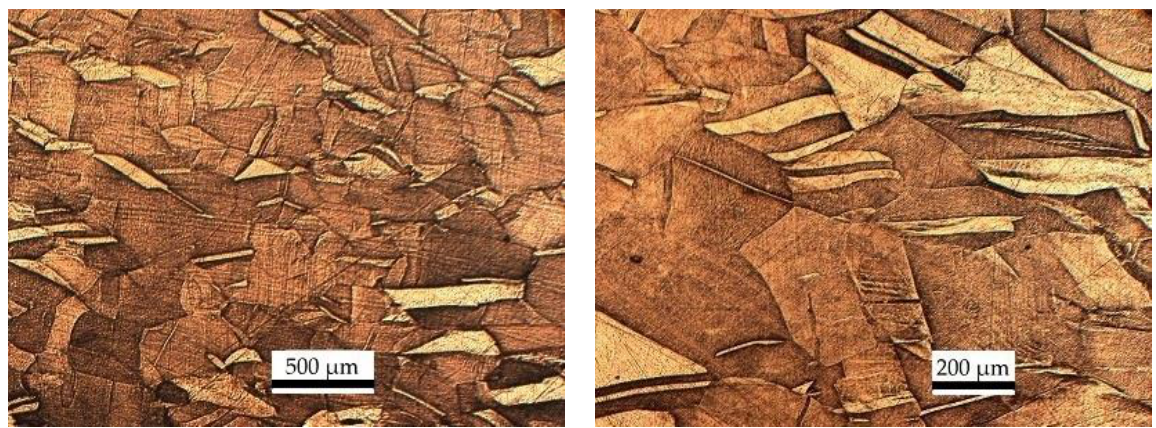
Figure 8. Microstructure of the elastic deformation zone for an impact velocity of 316 m/s.